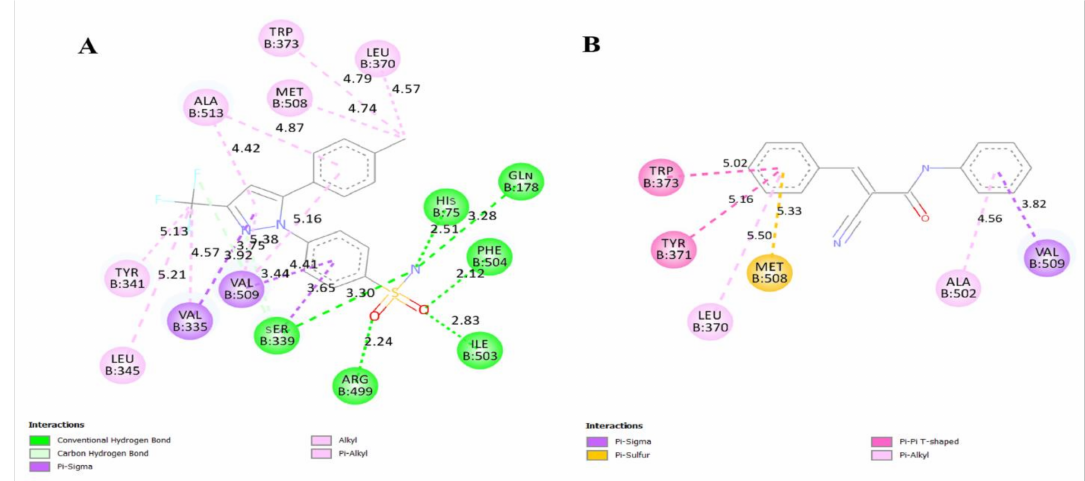
Figure 9. Ligand Celecoxib ( A ) and JMPR-01 ( B ) in COX-2 target (PDB ID: 3LN1). Arachidonic acid is also a 5-LOX substrate, and characterized as a crucial point in synthesis of leukotrienes and lipoxins, which are, respectively, (initiation and